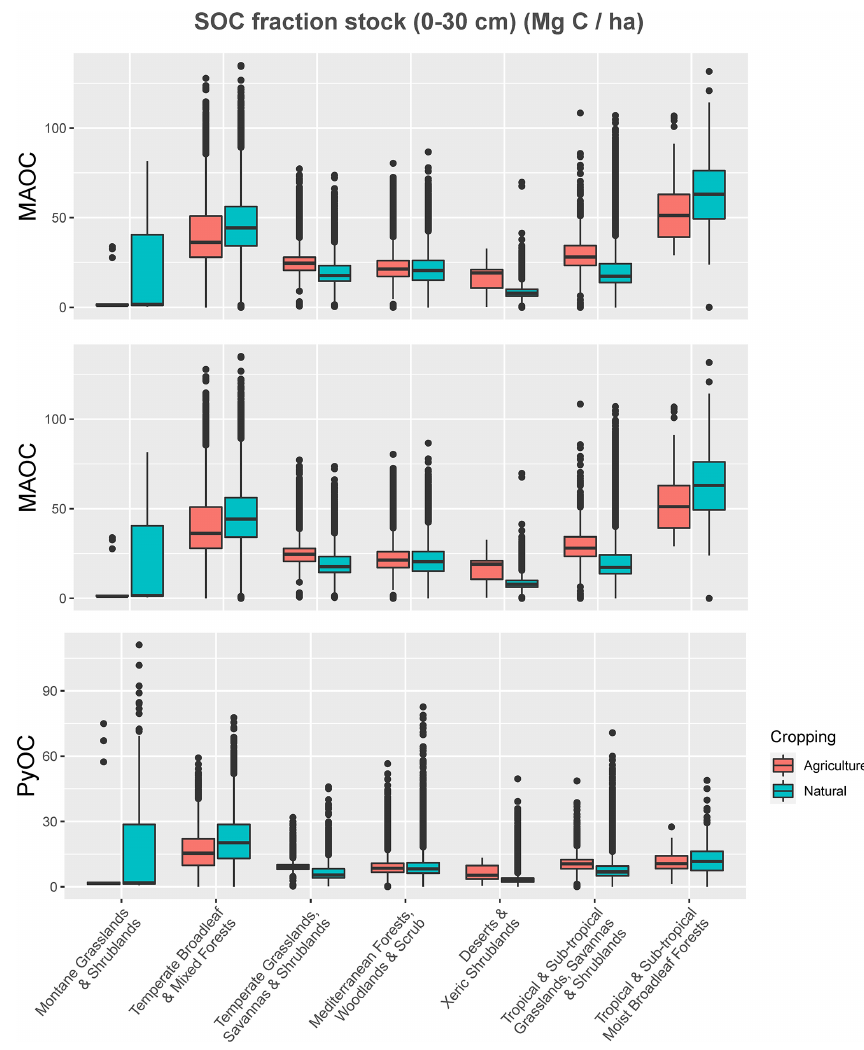
Figure 10. SOC fraction stock (MgCha − 1 ) by biome and land use. MAOC, POC, and PyOC.